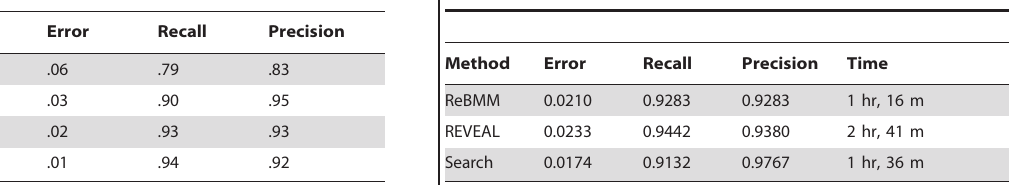
Table 5 Results for different methods on the SIGNET dataset.